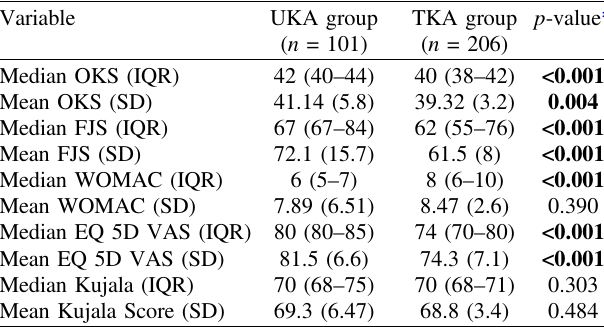
Table 2. Summary of outcomes at fi nal follow-up.